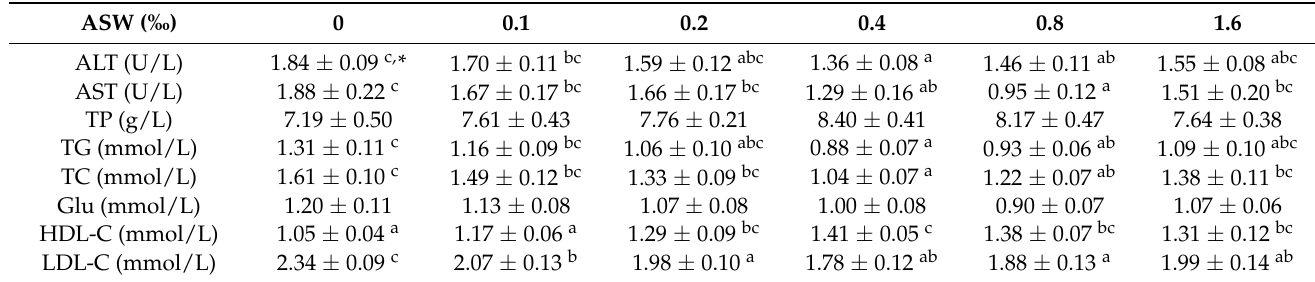
Table 5. Effect of ASW on serum biochemical parameters of GIFT (mean ± SEM).